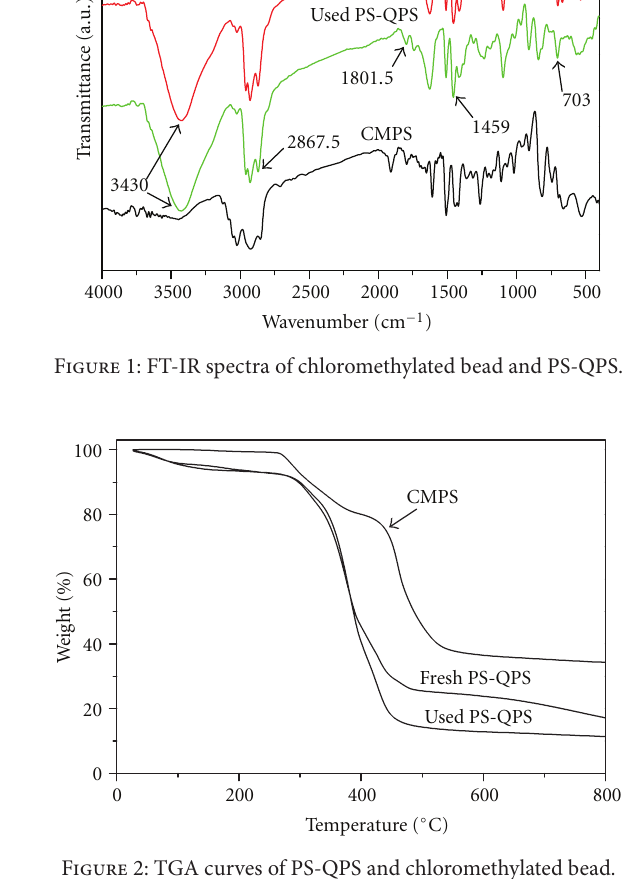
F 2: TGA curves of PS-QPS and chloromethylated